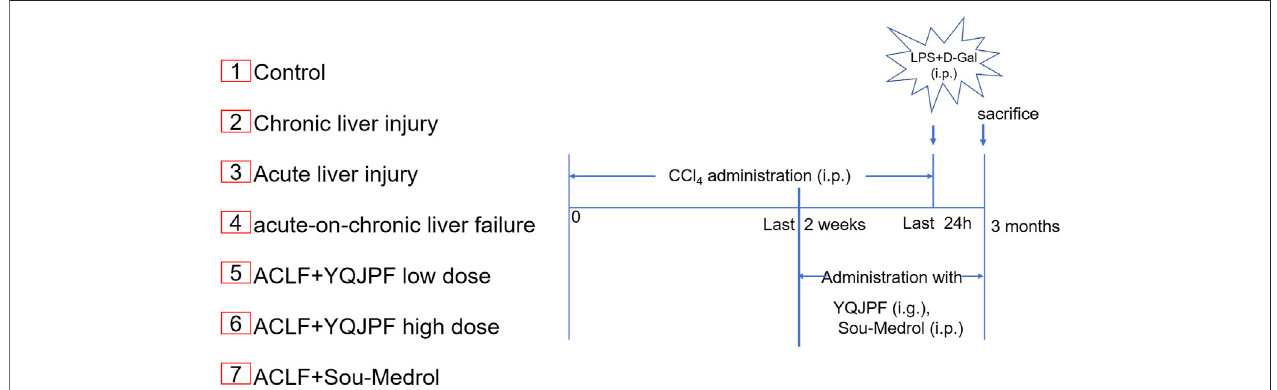
FIGURE2| Themajor componentsin YQJPF wereassessed using HPLC. Calycosin-7-O- β -D-glucoside,ferulic acid,hesperidin, and glycyrrhizic acidwere found to be in the amounts of 0.3676, 0.6639, 2.442, and 0.4028 mg/ml, respectively.